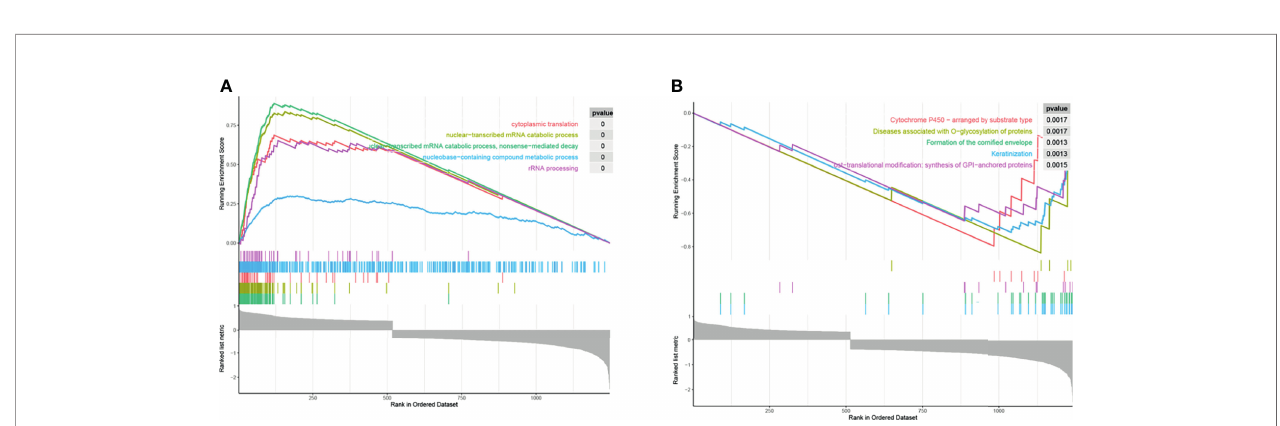
FIGURE 6 | Functional mining of RPS27A . (A) Gene Ontology (GO) terms of RPS27A . (B) Biological pathway of RPS27A in the Reactome gene set.